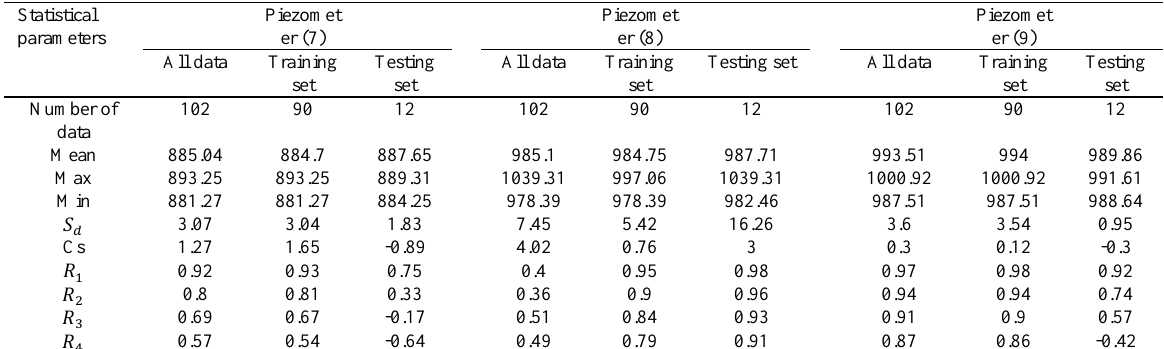
Table 4. Statistics analysis for training, testing and all data sets.